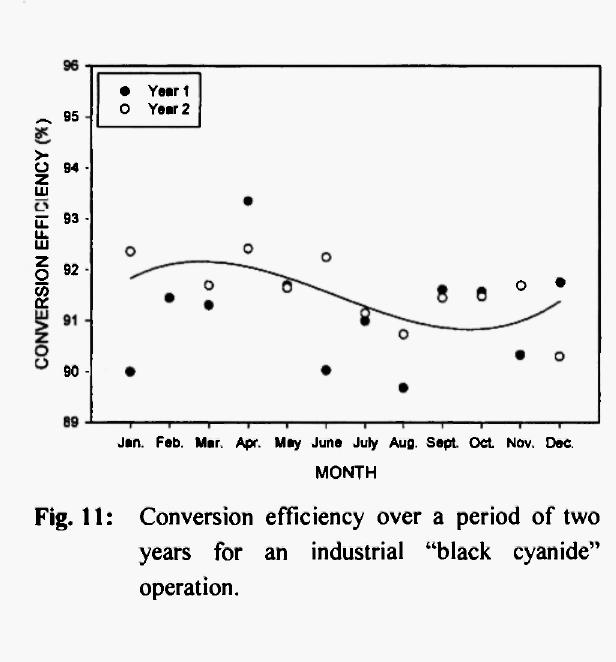
Fig. 11: Conversion efficiency over a period of two years for an industrial "black cyanide" operation.